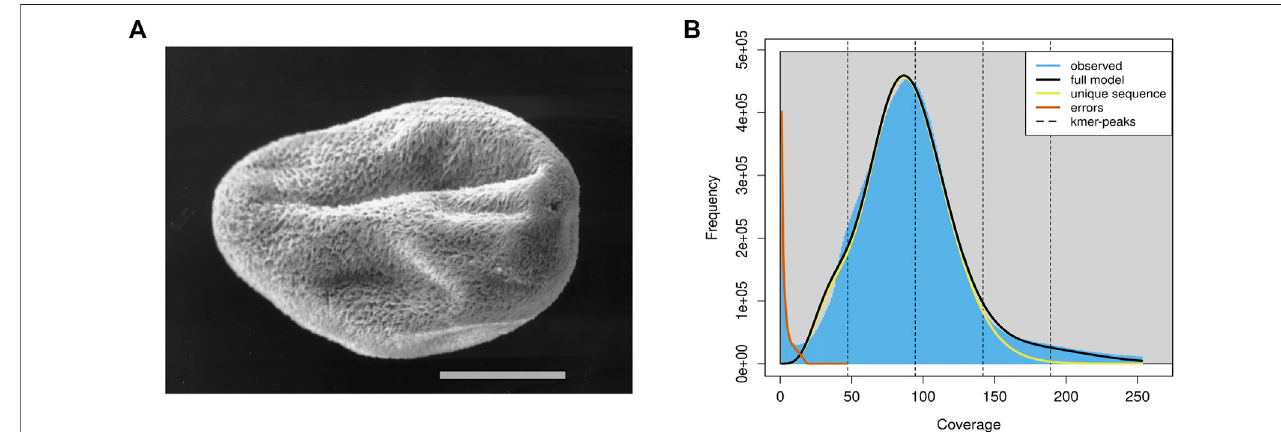
FIGURE 1 | The schematic diagram and genomics feature of the C. irritans . (A) Pro-tomont of the C. irritans . Scale bar 100 μ m [adopted from (Bresciani and Buchmann (2001)]. (B) A K-mer analysis of the genome sequencing reads for the C. irritans using